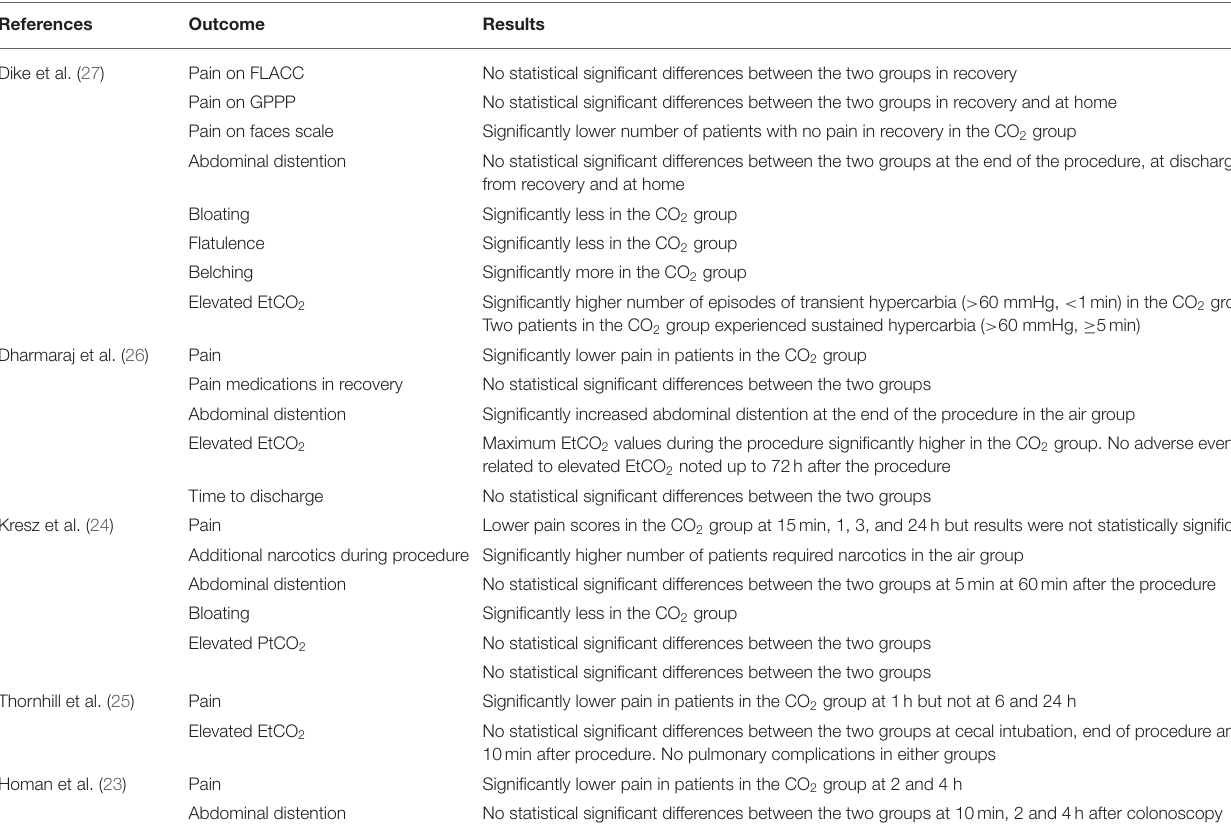
TABLE 3 | Descriptive analysis of outcomes in included